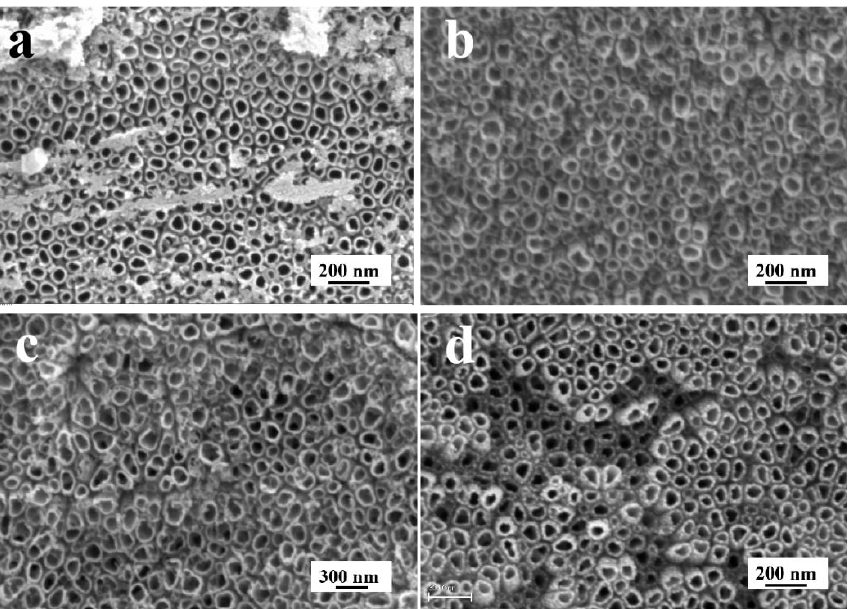
Figure 3. SEM images of Ti wire anodized in ethylene glycol solution of NH 4 F. Electrochemical anodization condition: time, 30 min; voltage, 20 V; temperature, 25 °C; electrolyte composition, NH 4 F concentration 0.50% ( ω %). The concentration of ethylene glycol ( v / v ): 20% ( a ), 50% ( b ), 60% ( c ), 80% ( d ).